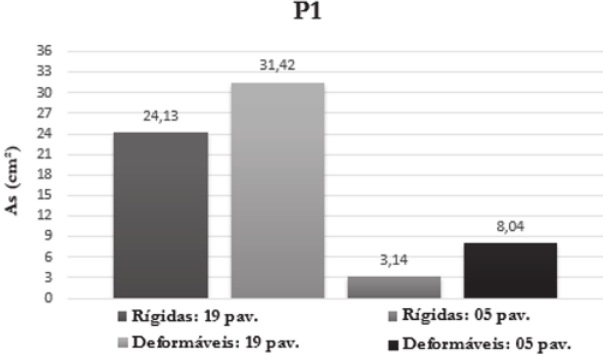
Figura 14 Modelo de Ferreira, El Debs e Elliot [1]: armadura do pilar P3 da estrutura com 19 e 5 pavimentos, considerando ligações rígidas e ligações